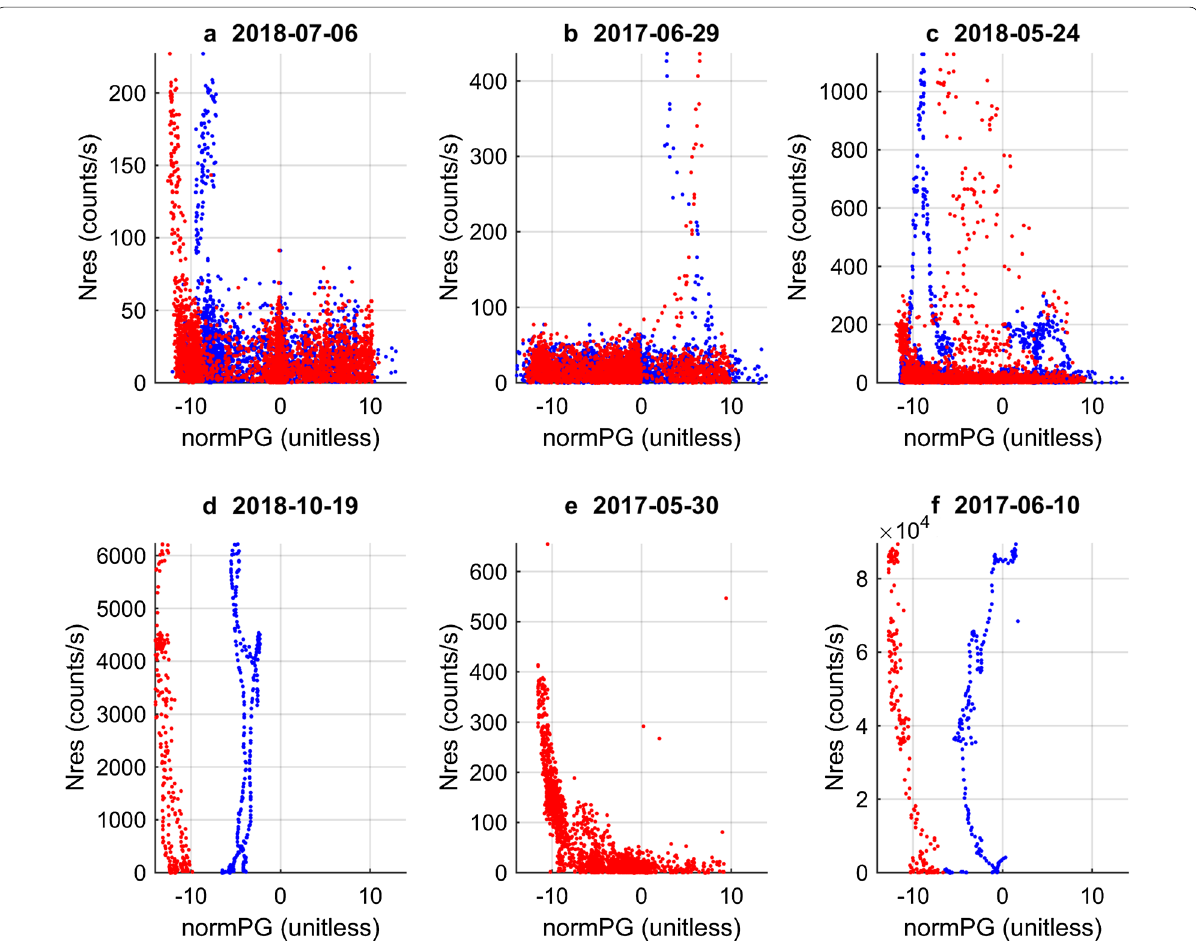
Fig. 12 Scatterplots between 1-s residual counts N res and normalized PG at Lomnicky peak (red) and Skalnate Pleso (blue) for the intervals (events) presented in Figs. 3, 4, 5, 6, 7 and